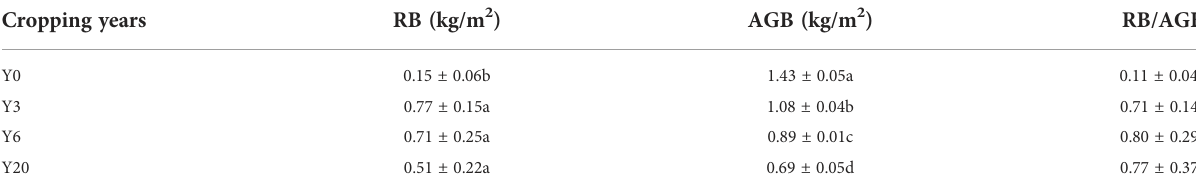
Different letters indicate signi fi cant differences among the four cropping